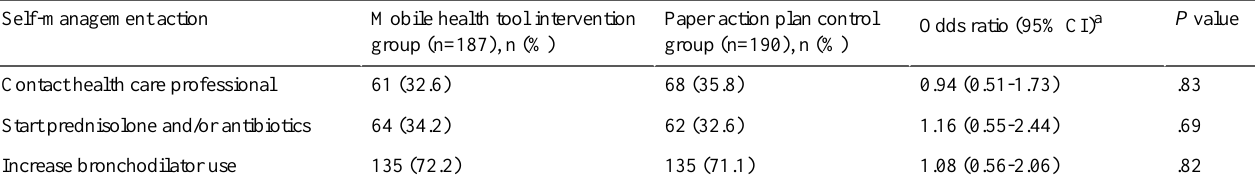
Table 3. Self-reported self-management behavior during exacerbation onset (N=377 exacerbations).